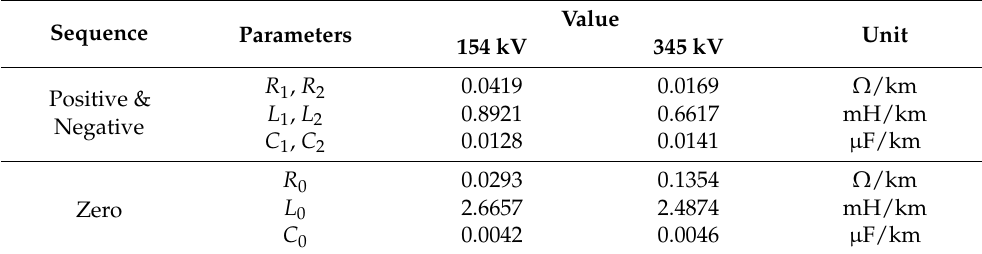
Table A1. The system data used for the testing part in the performance evaluation section is given in detail. The transmission line parameters used in this study is applicable in Korean